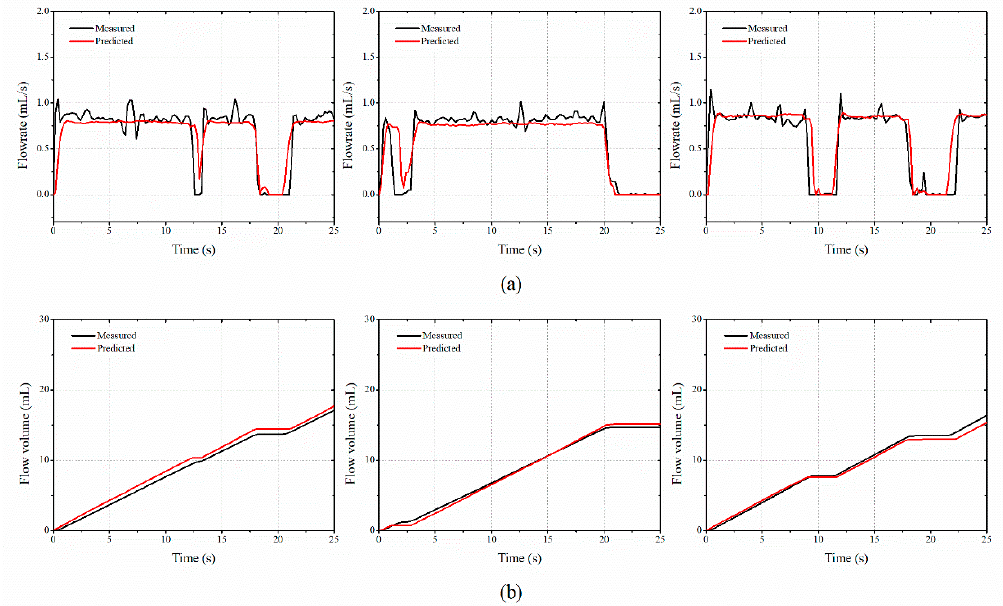
Figure 11. Comparison of the measured sand flow rate by using the proposed LSTM and vibration responses: ( a ) mass flow rate and ( b ) total mass flow. Table 2. Comparison of the root means square error of mass flow rate and relative error of the total mass.